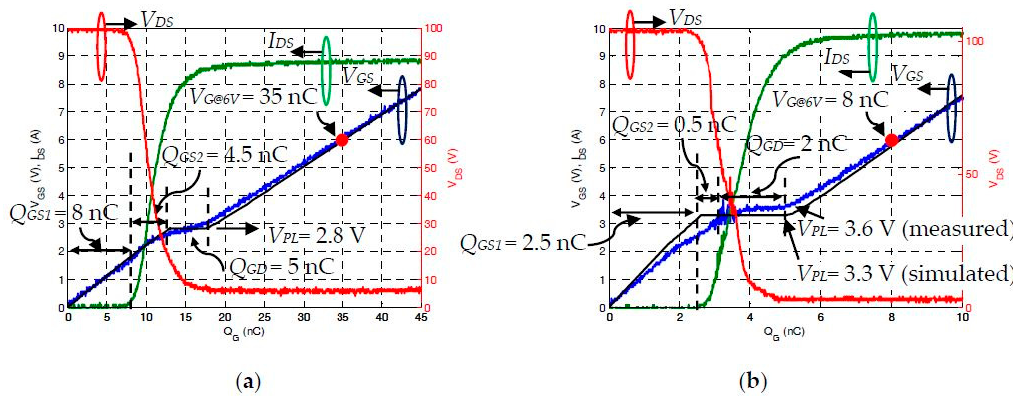
Figure 9. Gate-to-source voltage ( V GS ) versus total gate charge ( Q G ) of the ( a ) fabricated GaN FET and ( b ) commercial GaN FETs [TPH3006PS].